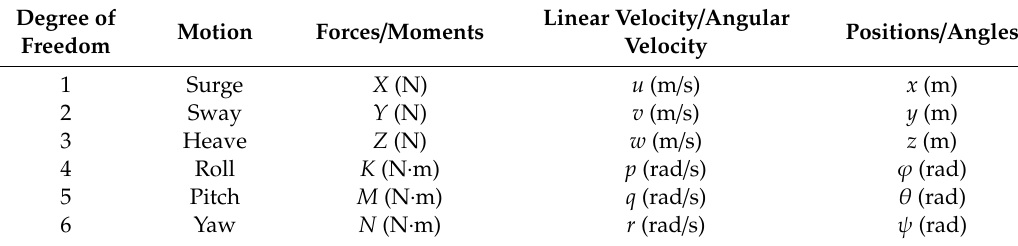
Figure 3. Vertical plane motion coordinate system. Table 2. Variables of FOS in its local coordinate